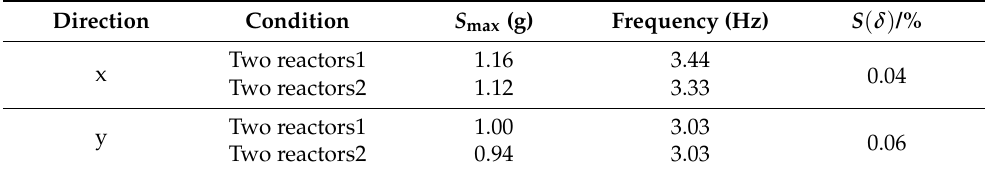
Table 11. Comparison of FRS at different locations of the raft foundation.